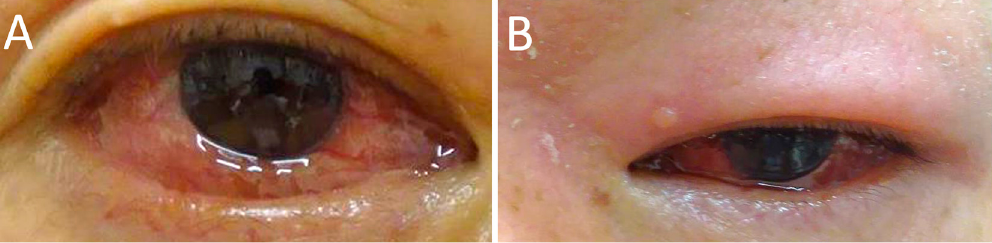
Figure 4. Conjunctivitis and eyelid edema in patients with RPC. Photographs show conjunctival edema and hyperemia ( A ) and swelling and redness of the upper eyelid ( B